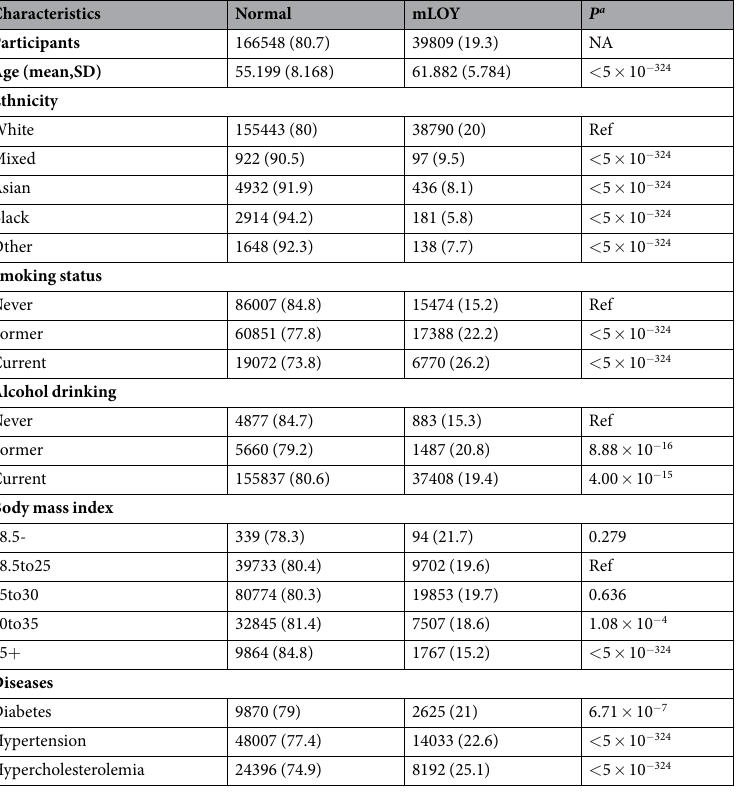
Table 1. Patient characteristics by mLOY status. Abbreviations: mLOY: mosaic loss of the Y chromosome. a Fisher’s exact test with mid- p